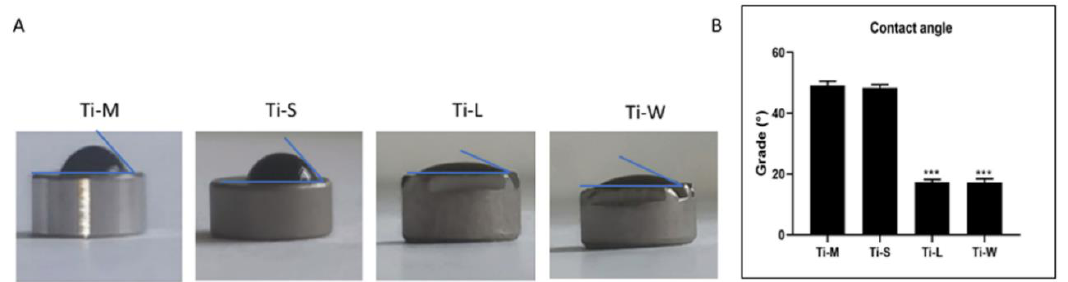
Figure 4. ( A ) Pictures of the WCA on the different surfaces, during the sessile drop method. ( B ) The average measured WCA (*** denotes statistically significant differences between machined and sand-basted/dual-etched group, p < 0.001).